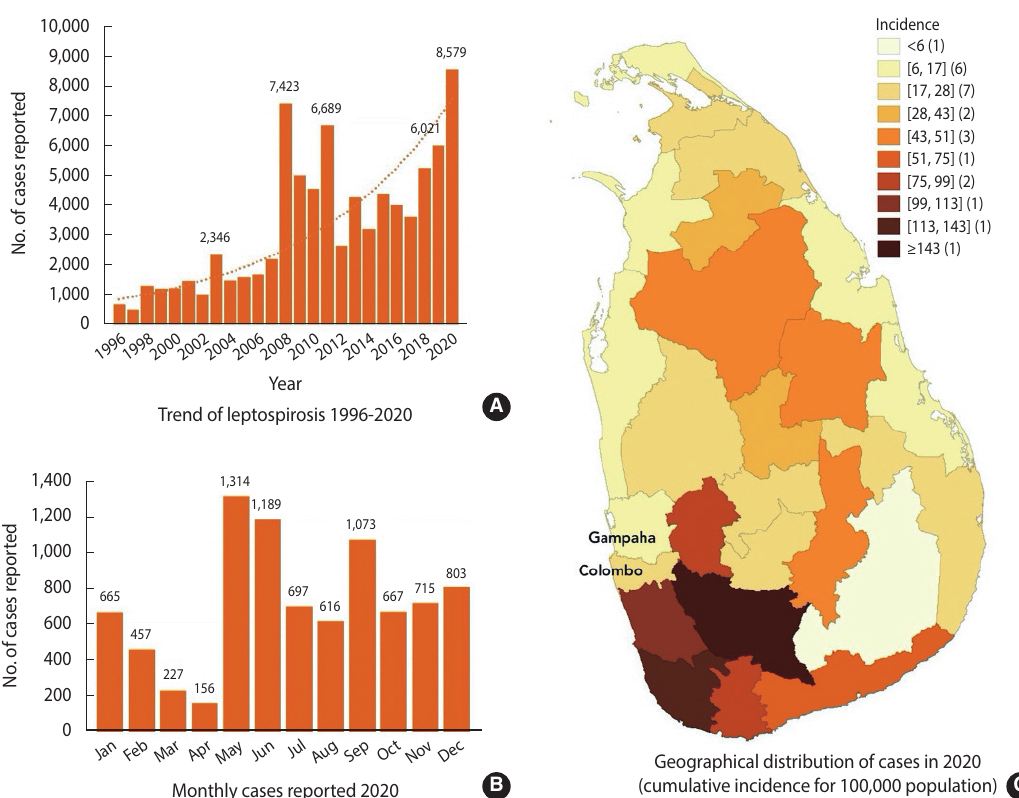
Figure 1. Trend of leptospirosis from 1996 to 2020 (A), monthly leptospirosis cases in 2020 (B), and spatial distribution of leptospirosis (C) in Sri